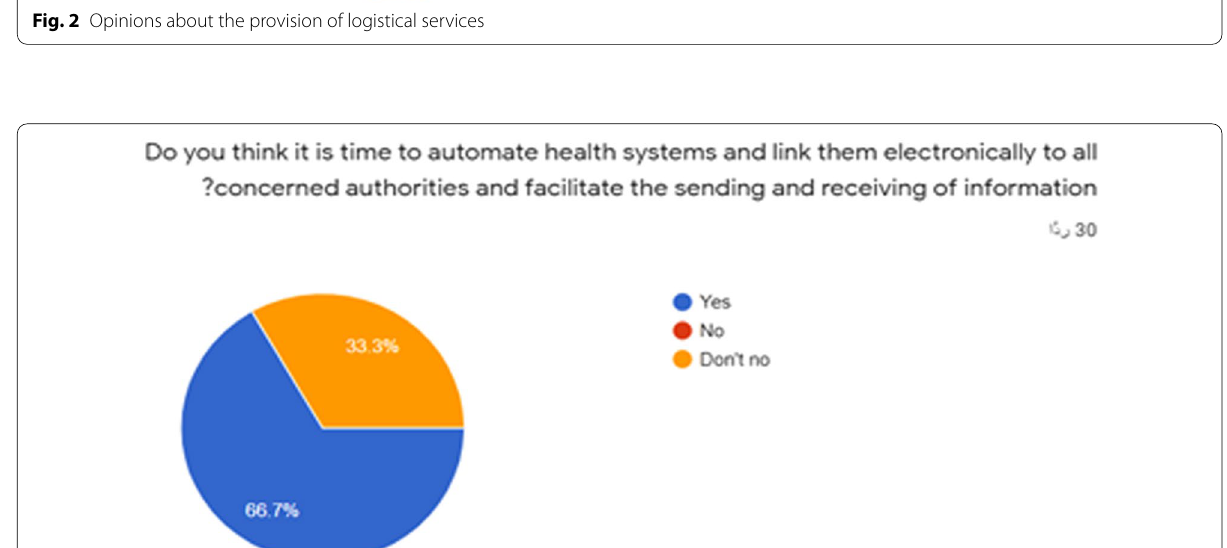
Fig. 3 Opinions about the automation of health